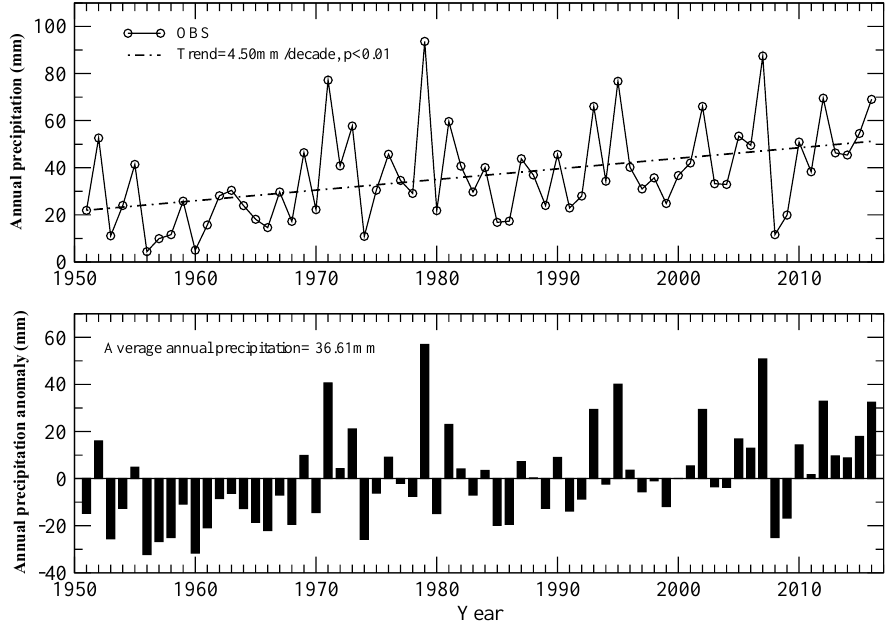
Figure 7. The time series plot of the annual precipitation and the trend ( top ); and annual precipitation anomaly plot ( bottom ).